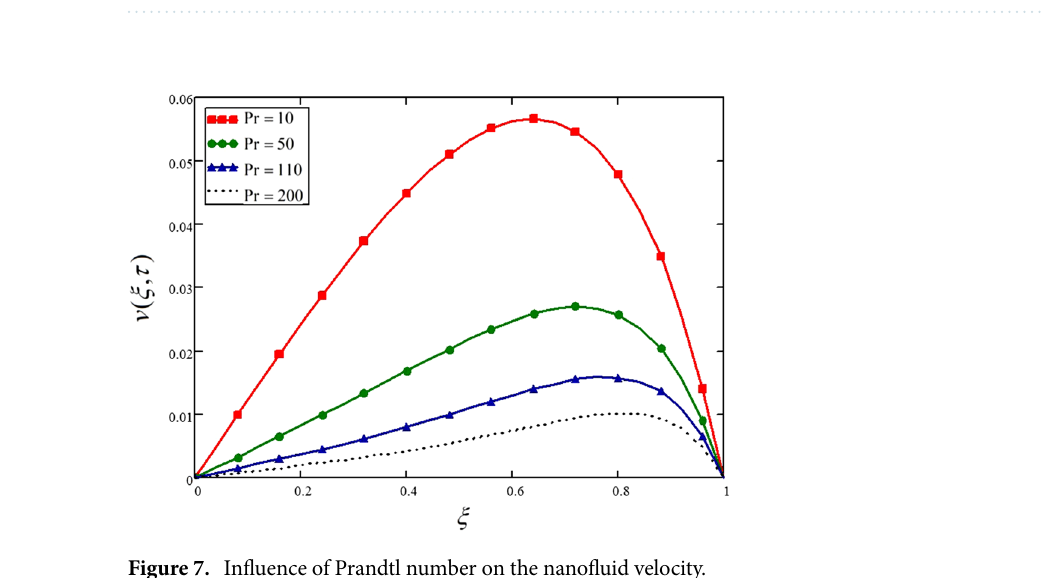
Table 6. Variations in velocity profile against ξ if h (τ) = 0 for different values of M .